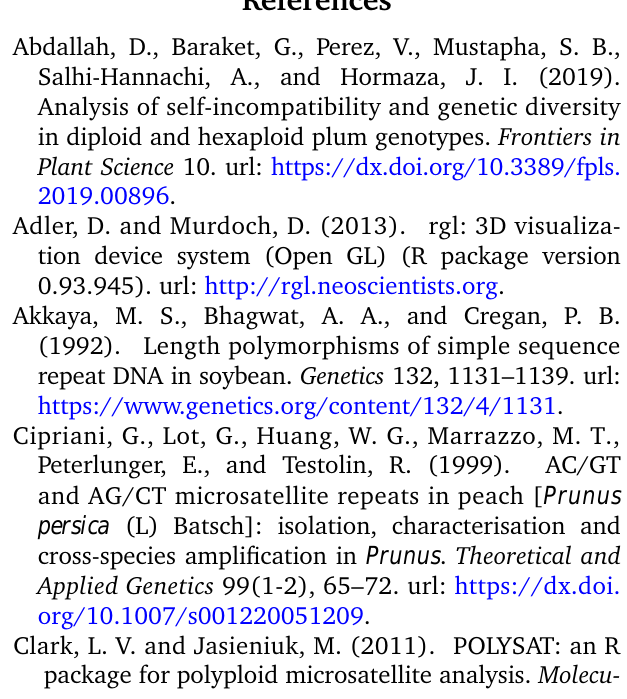
Supplementary Table 1. SSR profiles for 165 Euro- pean plum accessions. Sample numbers are the same